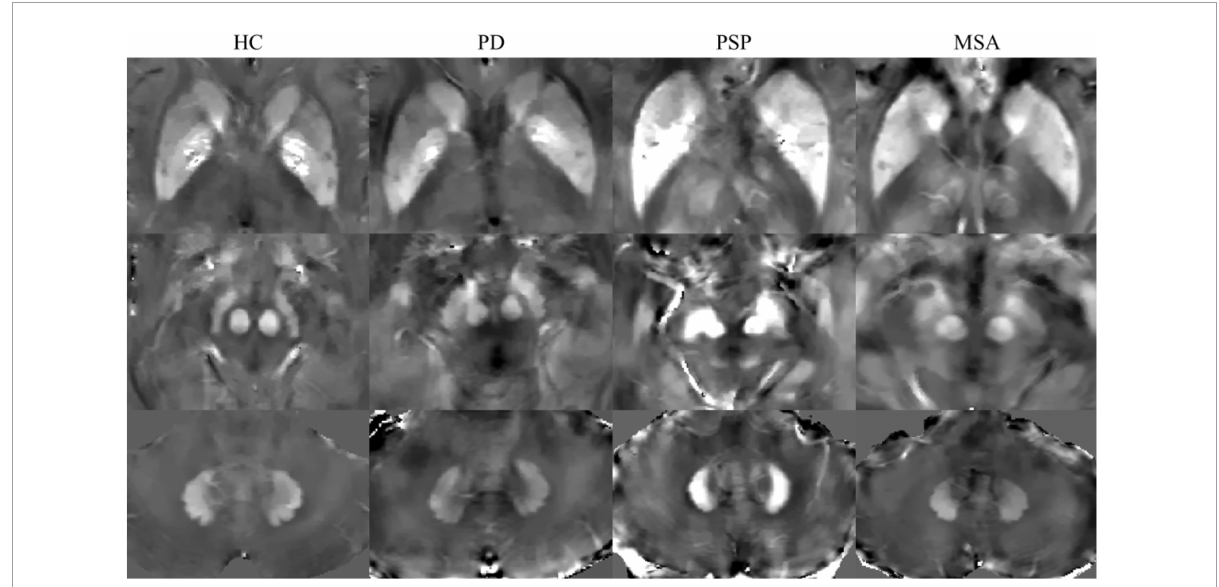
FIGURE1 Representative quantitative susceptibility mapping (QSM) images of HC, PD, MSA, and PSP. HC, healthy control; PD, Parkinson’s disease; PSP, progressive supranuclear palsy; MSA, multiple system atrophy.